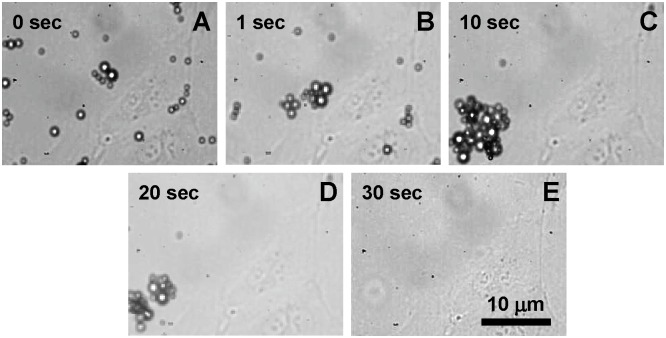
Optical recording of tMB on HUVECs during ultrasound treatment.(A) before treatment. (B-E) tMB displacement, clustering, and destroyment during 30 s insonification (1MHz, 80 kPa PNP, 10,000 cycles, repetition rate of 20 Hz, 30 s insonification treatment, SPIO added at -5 min with respect to the start of insonification).